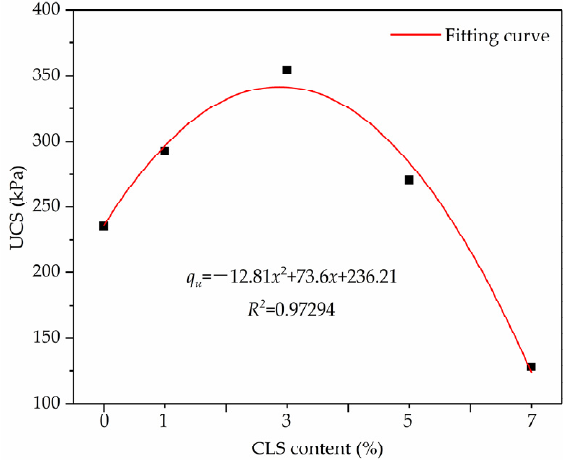
Figure 11. Curve of UCS with CLS content at 28 d curing age.